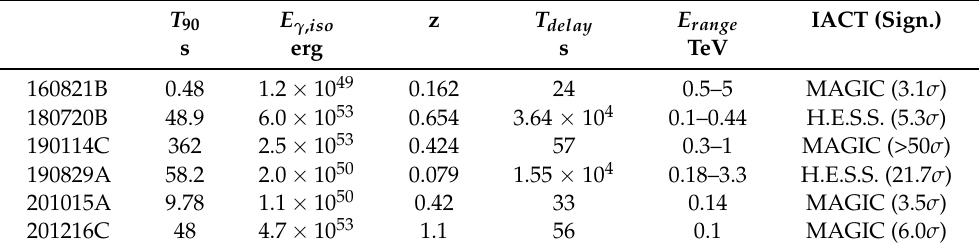
Table 4. List of the GRBs observed by IACTs with a firm detection (significance > 5 σ ) or a hint of detection (3–4 σ ) above 100GeV. The T 90 and E γ , iso refer to the duration and total emitted energy of the prompt emission; the redshift is listed in column 3; T delay is the time delay between the trigger time T 0 and the time when IACT observations started; E range defines the energy range of the detected photons. The name of the telescope which made the observation and the significance of the detection are listed in the last